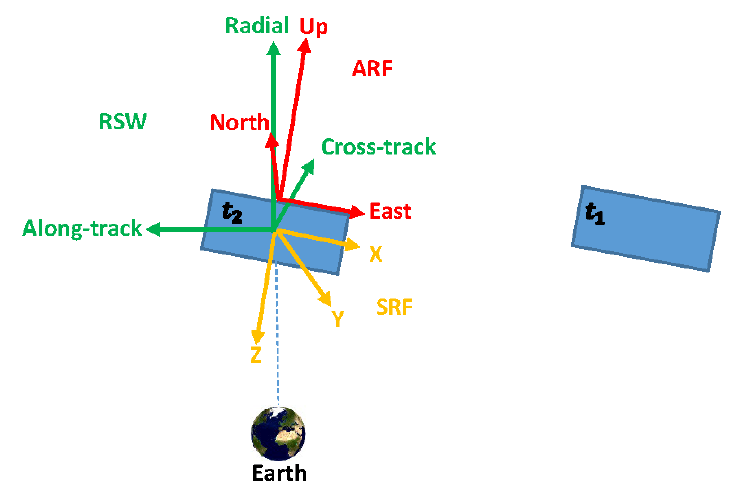
Figure 10. The antenna reference frame (ARF, shown in red), the satellite reference frame (SRF, shown in yellow), and the radial, along-track, and cross-track (RSW, shown in green) system. 𝑡 1 and 𝑡 2 represent two conservative time epochs for the same satellite. The figure is scaled for a better presentation.